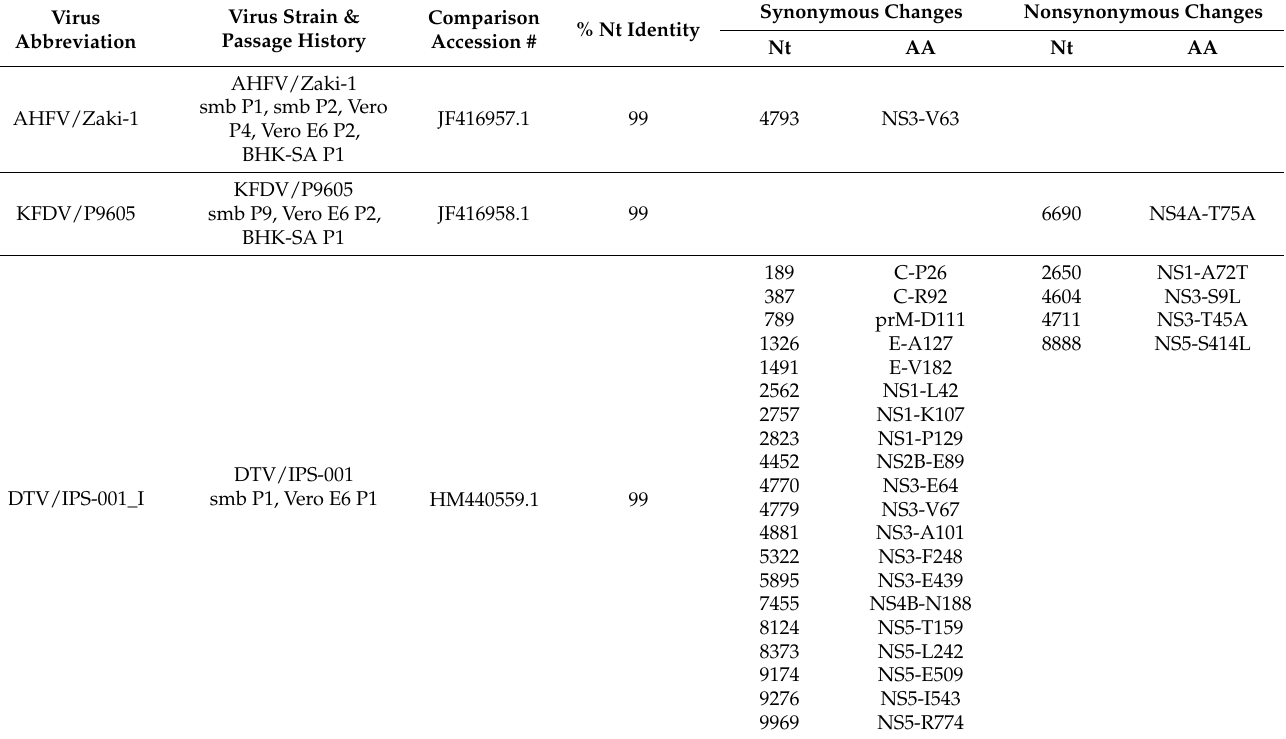
Table 1. Differences in coding region of sequenced viruses compared to those previously published in